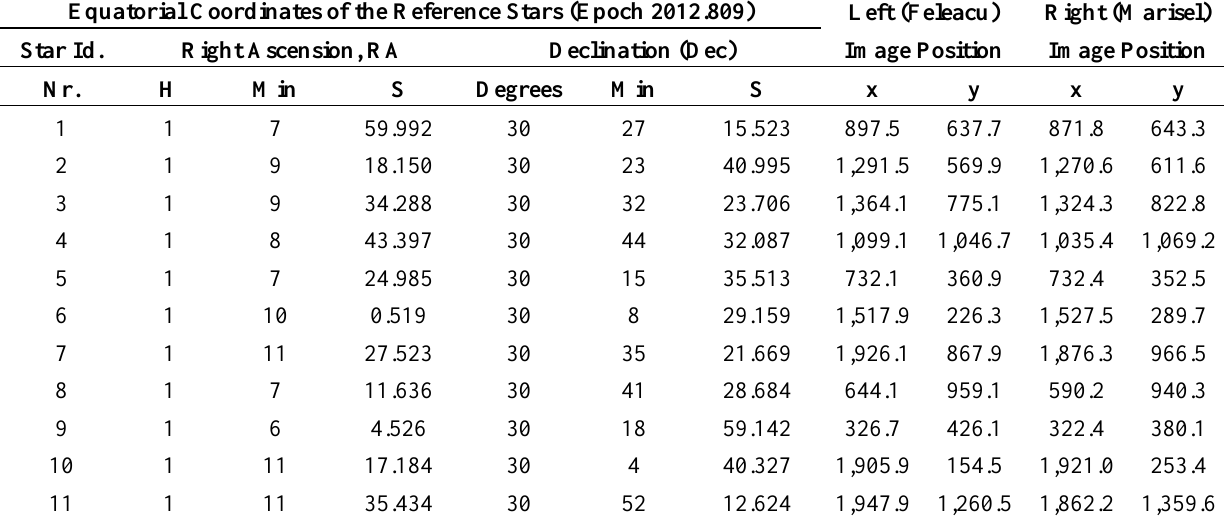
Table 1. Reference stars used for intrinsic calibration of the cameras. Equatorial Coordinates of the Reference Stars (Epoch 2012.809) Left (Feleacu)